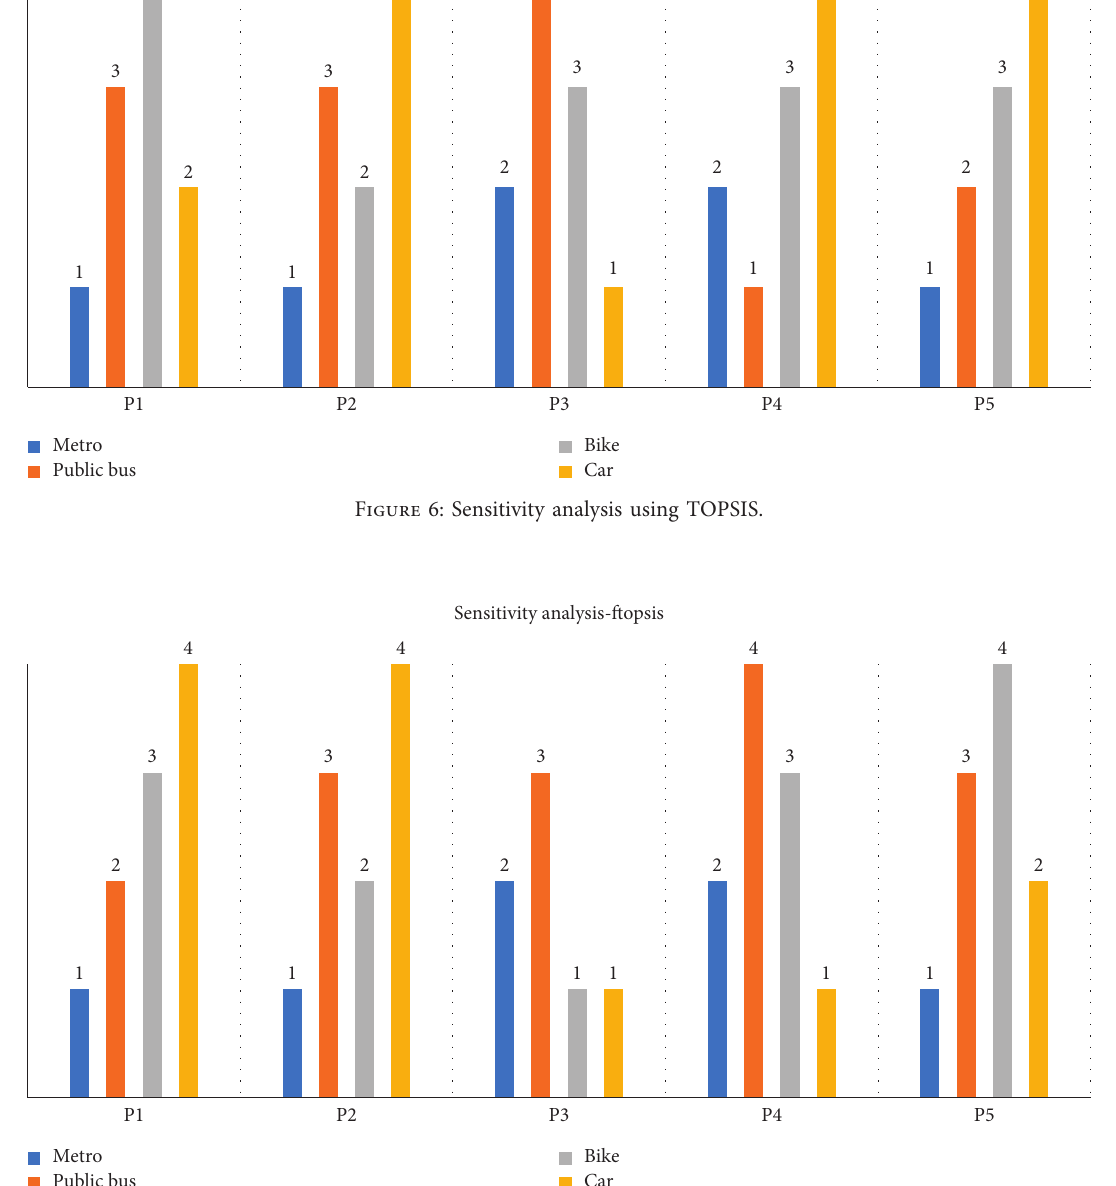
Figure 7: Sensitivity analysis using Fuzzy